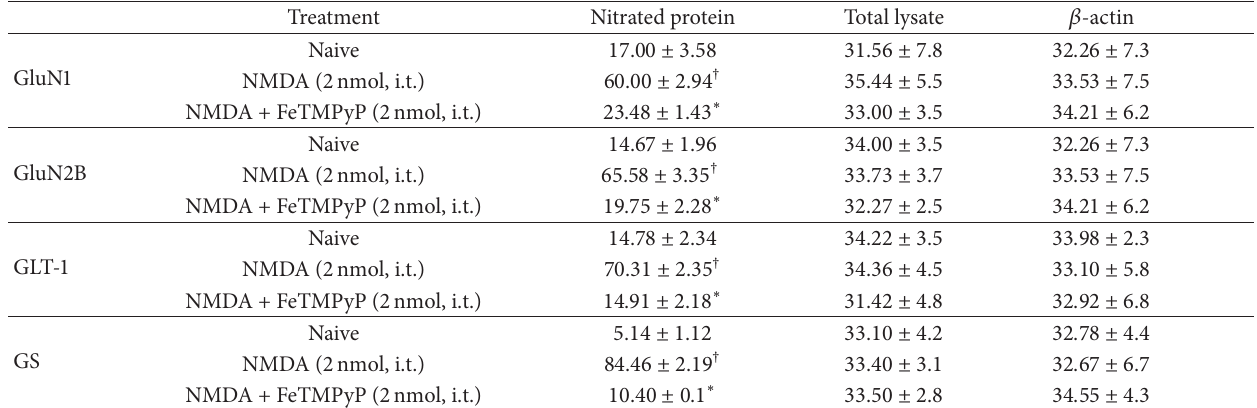
Table 1: Densitometry data expressed in %.